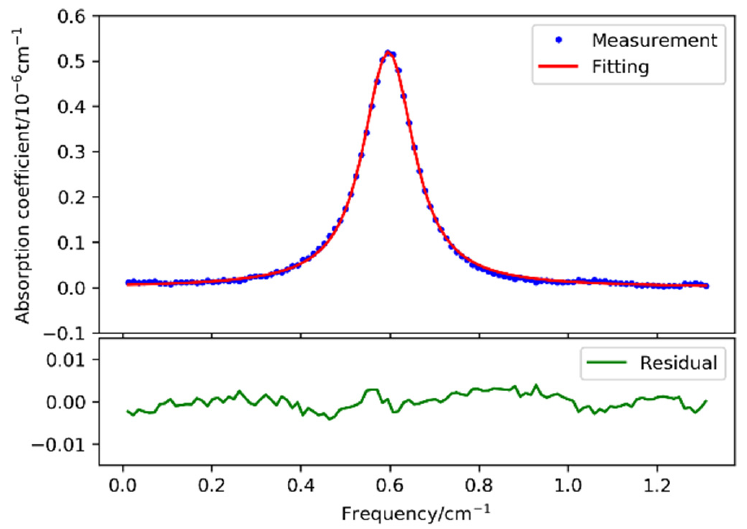
Figure 5. Schematic of the stepwise spectral scanning.